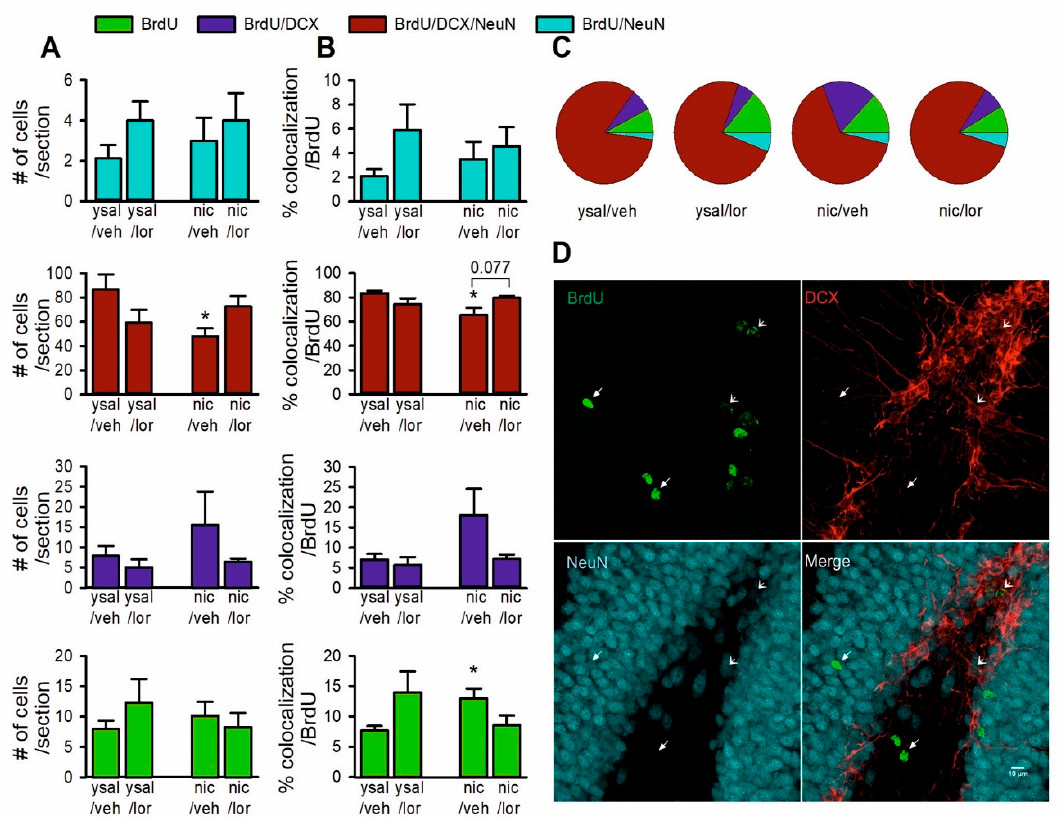
Figure 5. Effects of chronic lorcaserin administration on the maturation of newly generated cells in the hippocampal dentate gyrus (DG) during nicotine withdrawal (day 14). ( A ) Effects of chronic exposure of nicotine (nic)-withdrawn rats to lorcaserin (0.1 mg/kg, lor(0.1)) on the number of proliferating cells (single 5-bromo-2’-deoxyuridine(BrdU)-labeled cells), immature cells (double (BrdU/DCX)- or triple (BrdU/doublecortin(DCX)/NeuN)-labeled cells) or mature neuronal cells (double (BrdU/NeuN)-labeled cells). ( B ) Effects of lor(0.1) treatment on the percent of BrdU, BrdU/DCX and BrdU/DCX/NeuN cell types per total BrdU cell population during nic withdrawal. ( C ) A pie chart showing the percentage distribution of each BrdU cell population. ( D ) Representative confocal microscopy Z-plane stacks of images show BrdU (green), DCX (red) and NeuN (blue) immunofluorescence labeling in the control (ysal/veh) animal (single- or triple-labeled cells indicated by the simple or modified white arrows, respectively). Scale bar: 10 µ m. For more details, see Figure 4. The data are expressed as the means ( ± SEM). ysal/veh: n = 4; ysal/lor(0.1): n = 5; nic/veh: n = 4; nic/lor(0.1): n = 4. ( A ) * p < 0.05 versus ysal/veh, ( B ) % of colocalized BrdU/BrdU: * p < 0.05 versus ysal/veh; % of BrdU/DCX/NeuN colocalization/BrdU: * p < 0.05 versus ysal/veh.